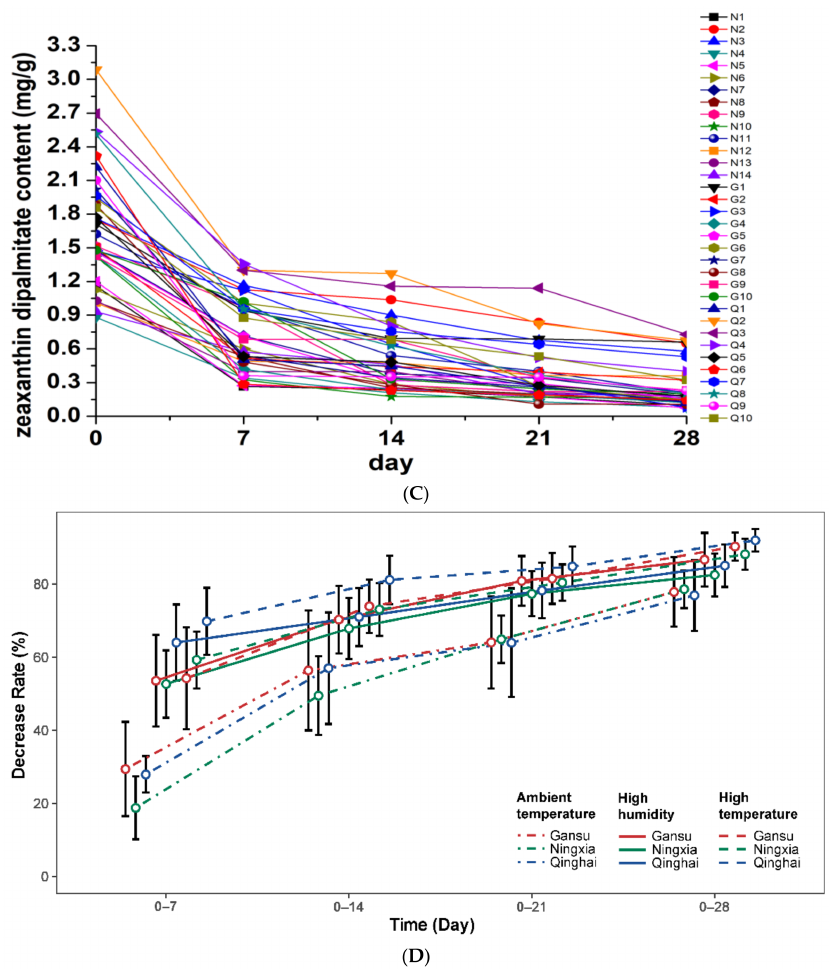
Figure 4. Determination results and decrease rates of zeaxanthin dipalmitate (mg/g) in 34 batches of LB under different storage conditions from day 0 to day 28. ( A ) content of zeaxanthin dipalmitate (mg/g) in LB under ambient temperature (25 ± 5 ◦ C); ( B ) content of zeaxanthin dipalmitate (mg/g) in LB under high temperature (45 ± 5 ◦ C); ( C ) content of zeaxanthin dipalmitate (mg/g) in LB under high humidity (RH 75 ± 5%); ( D ) decrease rates of zeaxanthin dipalmitate in LB under ambient temperature, high temperature and high humidity,